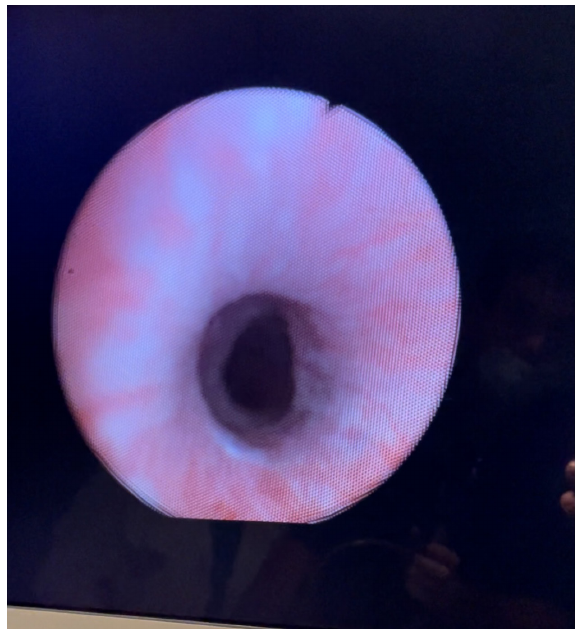
Figure 6. Urethroscopy 6 months after artificial sphincter placement: good urethral